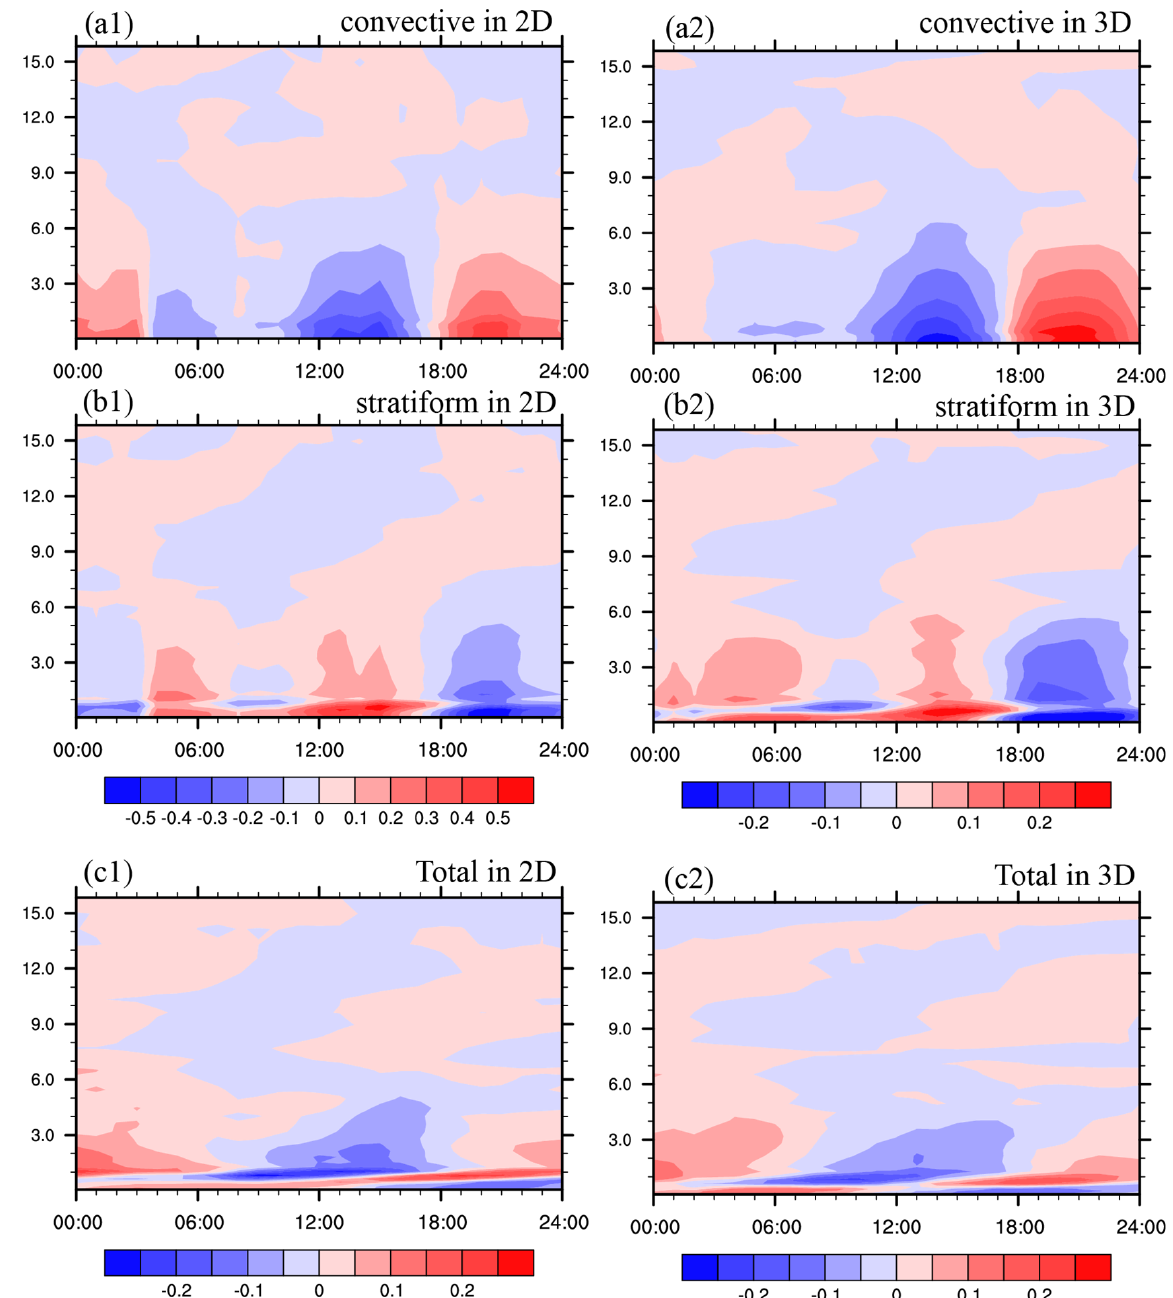
Figure 11. Diurnal composite of the perturbed water vapor mixing ratios (g kg − 1 ) in the 2D ( left panel ) and 3D ( right panel ) model runs in ( a1 , a2 ) convective regions, ( b1 , b2 ) stratiform regions, and ( c1 , c2 ) the model domain. The perturbed values are calculated by subtracting the average water vapor mixing ratios.